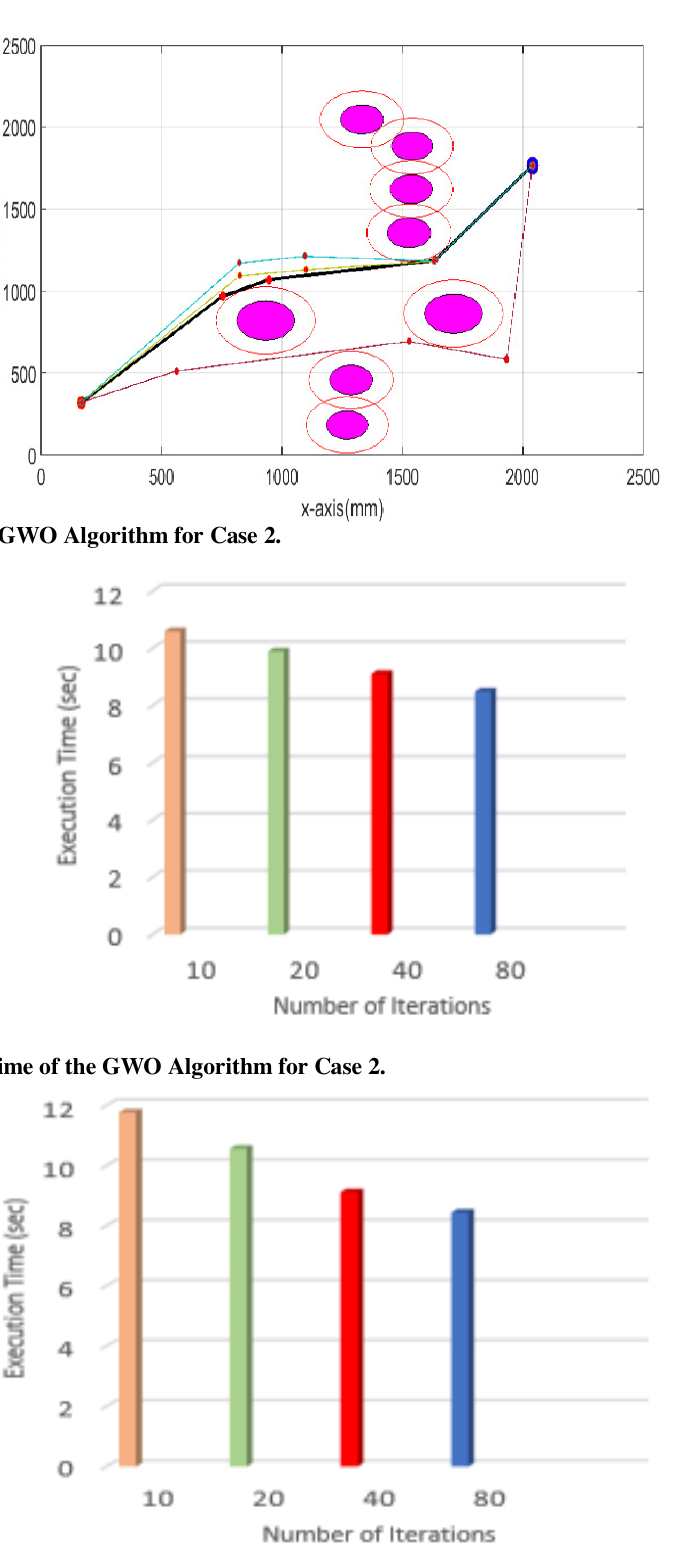
Fig. 17. The execution time of the GWO Algorithm for Case